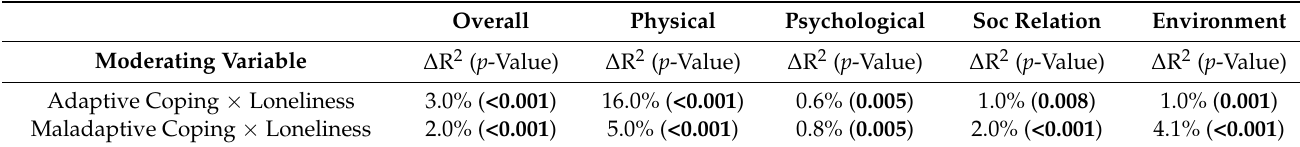
Table 7. Test of coping style as a moderating variable between loneliness and QoL in the transgender